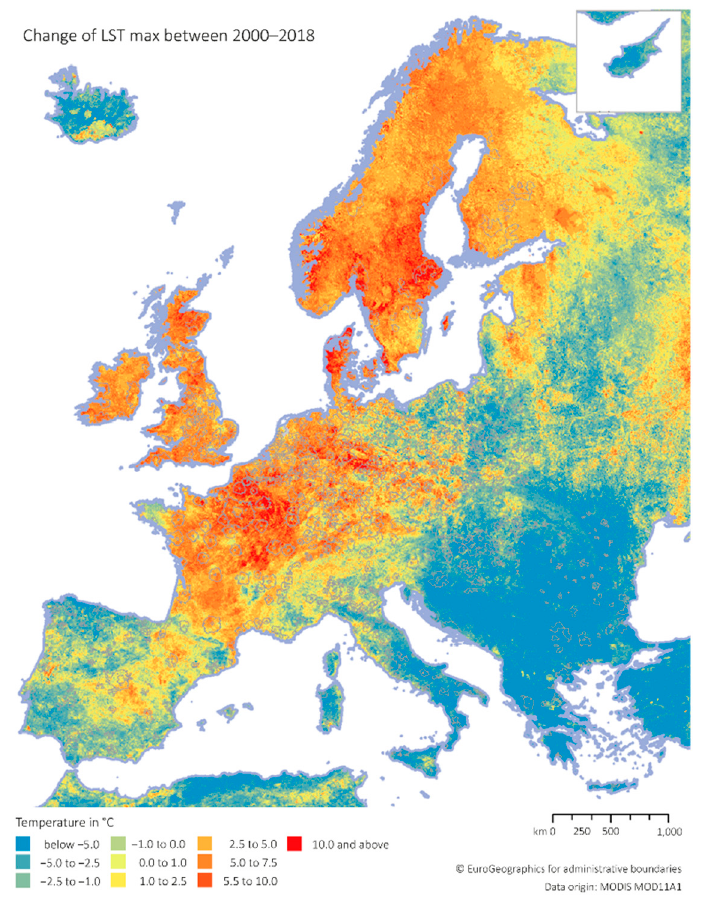
Figure 4. Change of maximum LST 2000–2018. Calculated from MODIS MOD11A1.